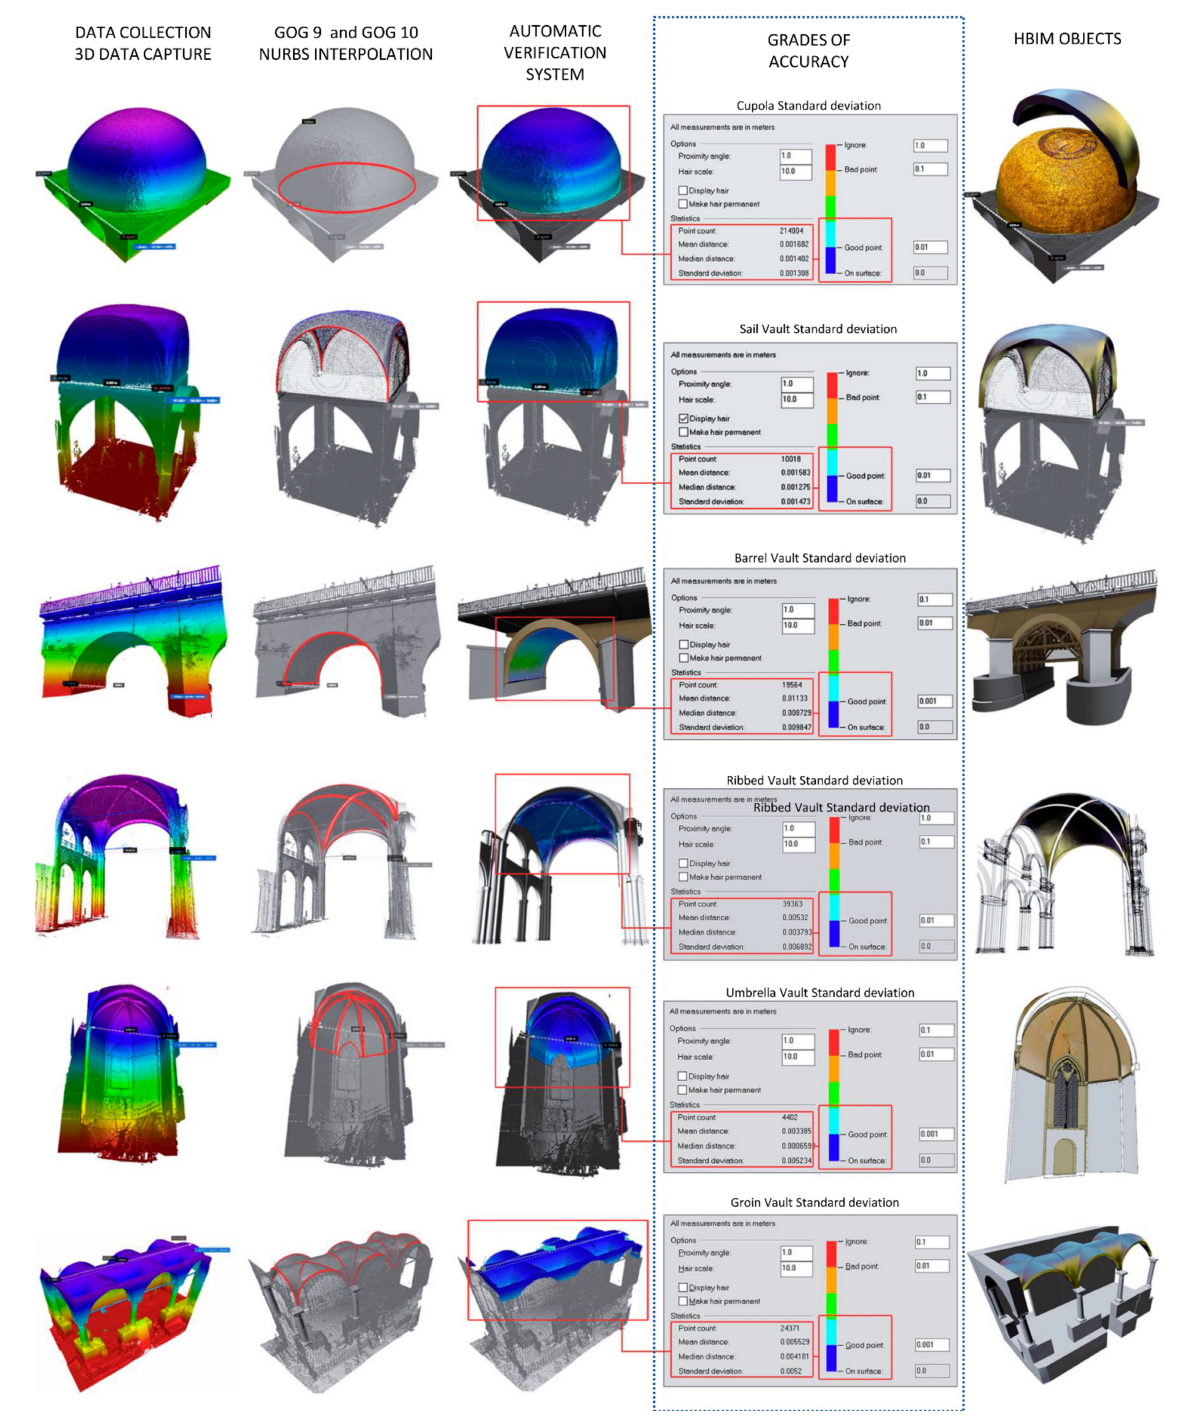
Figure 11. The automatic verification system (AVS) defined the reliability of complex HBIM objects in metric and geometric